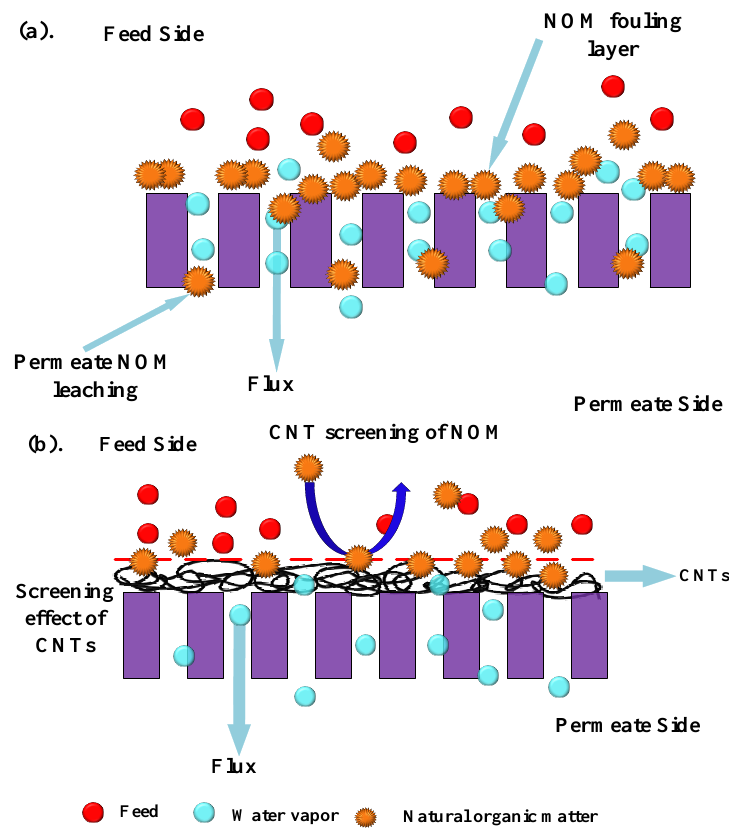
Figure 11. Mechanism: ( a ) Leaching of NOMs through the PTFE membrane pore. ( b ) Screening mechanism of CNTs to prevent NOMs leaching.